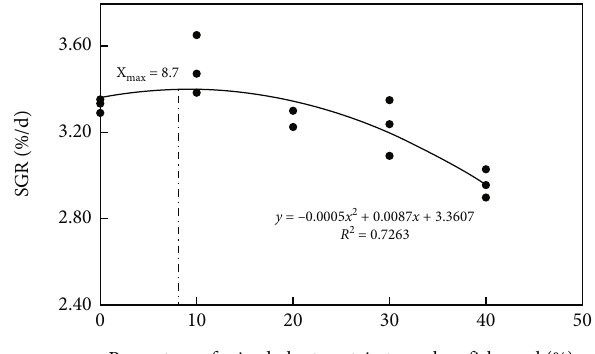
Figure 1: The relationship between SGR and dietary mixed plant protein replacement level in yellow cat fi sh for 10